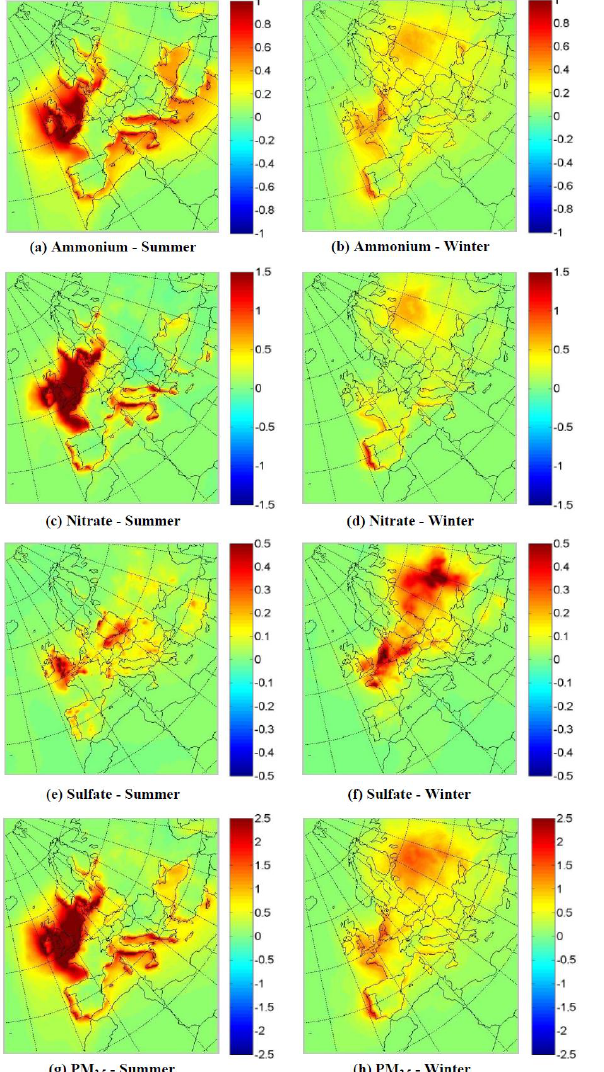
Fig. 3. Predicted reduction (base case – emissions reduction sce- Figure 3. Predicted reduction (base case - emissions reduction scenario) in ground-level 3 nario) in ground-level concentrations (µgm − 3 ) of (a–b) ammo- concentrations (μg m -3 ) of (a-b) ammonium, (c-d) nitrate, (e-f) sulfate, and (g-h) total PM 2.5 4 nium, (c–d) nitrate, (e–f) sulfate, and (g–h) total PM 2 . 5 after a 50% after a 50% reduction of NH 3 emissions during the modeled summer and the modeled winter 5 reduction of NH 3 emissions during the modeled summer and the modeled winter period. A positive value corresponds to a decrease. period. A positive value corresponds to a decrease. 6